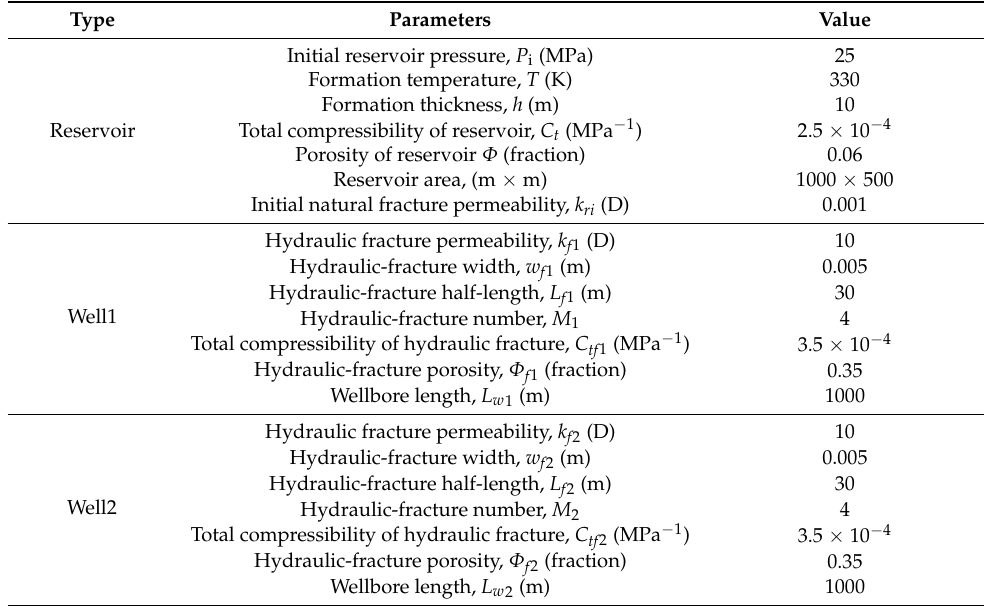
Table 1. The basic input parameters in numerical